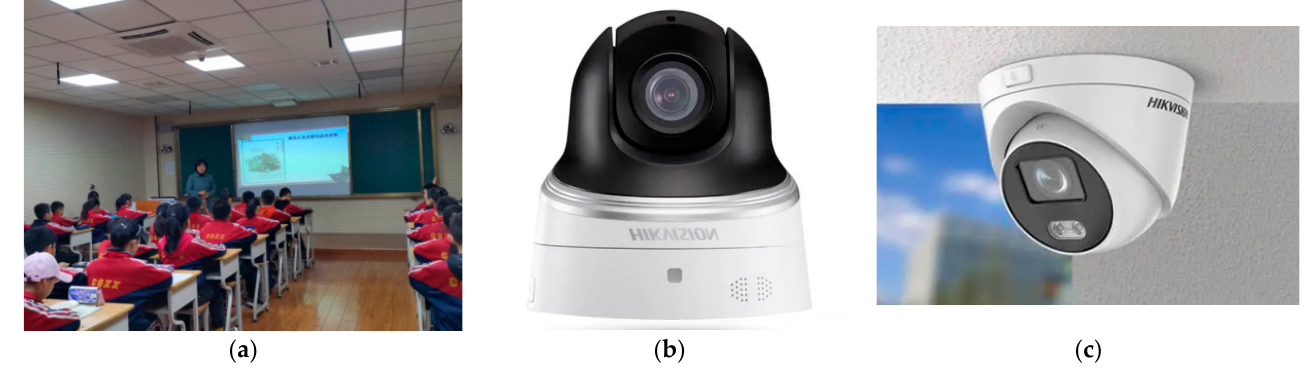
Figure 5. Experimental environment and equipment. ( a ) Smart class; ( b ) iDSEGD0288-HFR; ( c )